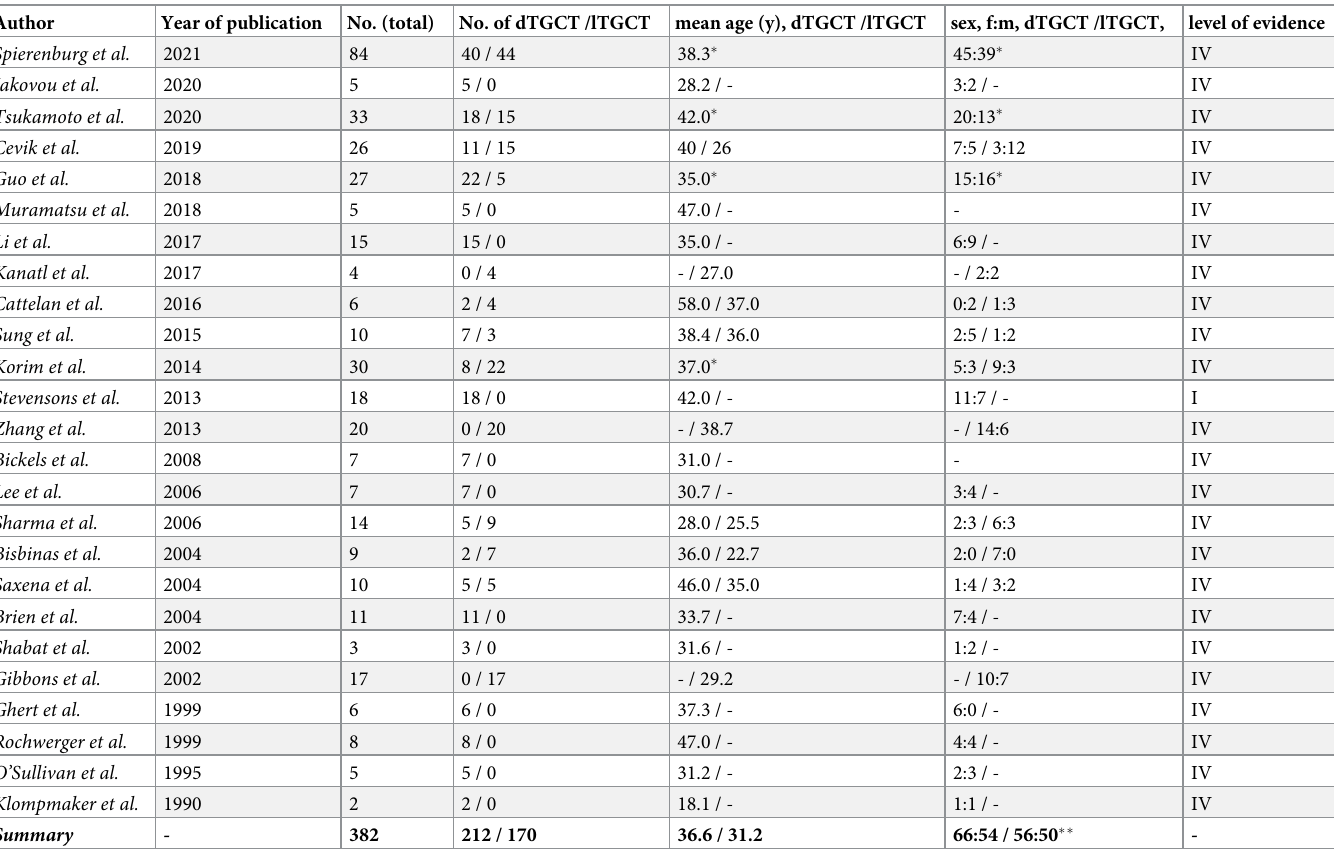
Table 1. Patient demographics and study